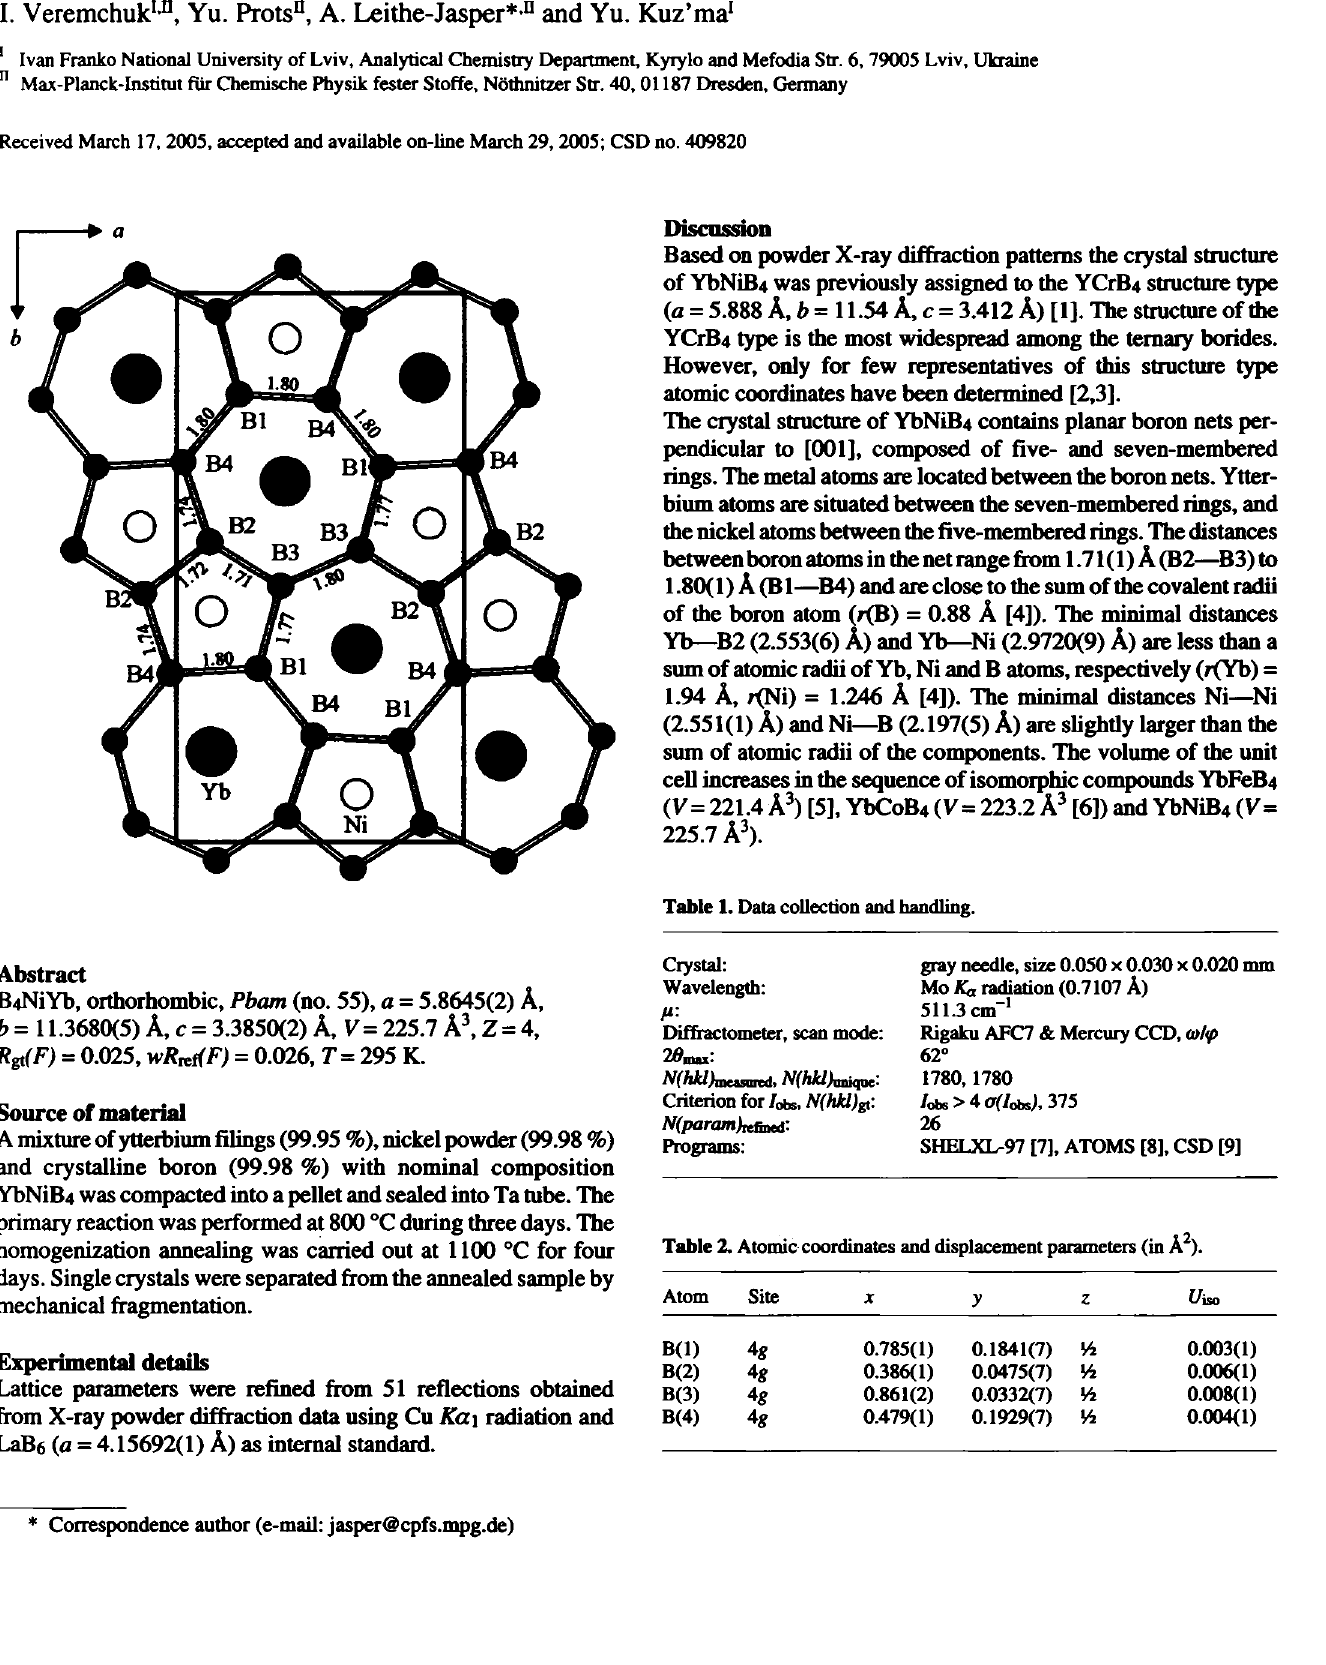
Table 2. Atomic coordinates and displacement parameters (in A 2